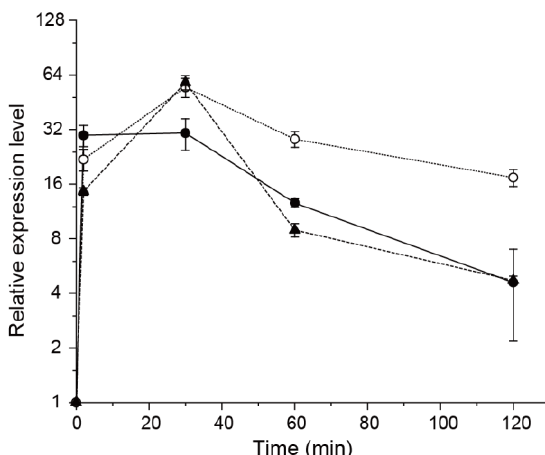
Figure 3. Responsiveness of SqrR regulated gene to sulfide. Temporal changes in the relative level of sqr gene transcripts after treatment with sulfide compared with 0 min in WT (filled circles), Δ trxC (open circles), and trxC complementing strain (filled triangles) cells. Cells were cultured to the mid-log phase under aerobic conditions, and 0.2 mM sodium sulfide was added at t = 0. Cells were harvested at each time point and assayed by qRT-PCR. Data shown are mean ± S.E. from three biological replicates (error bars).